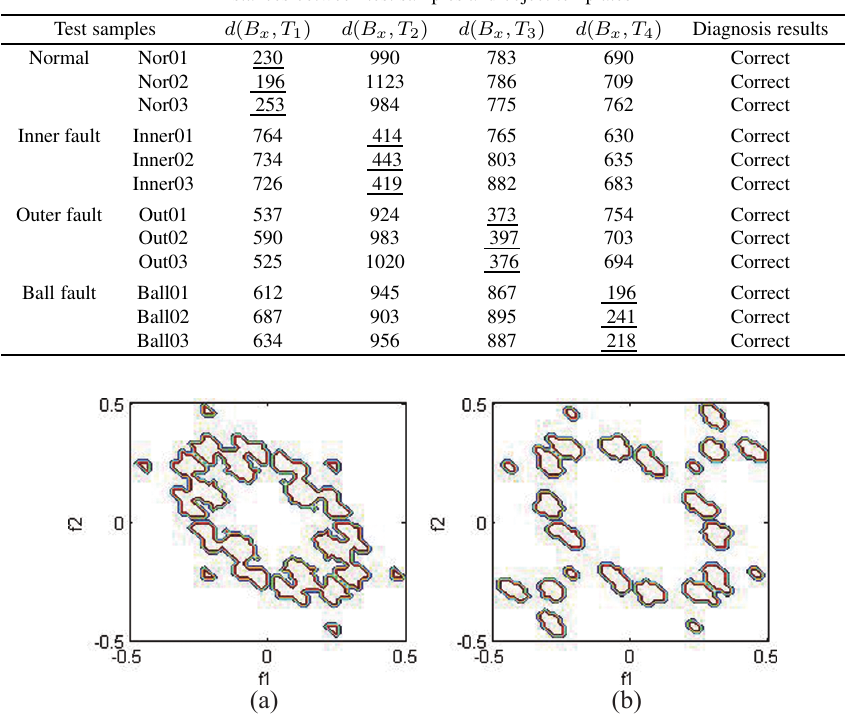
Table 4 Distances between test samples and object templates